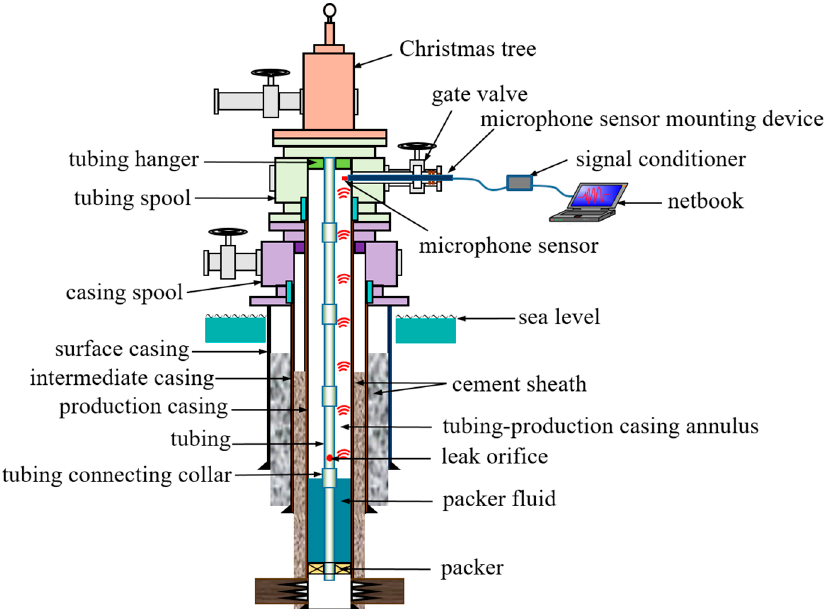
Figure 1. Schematic of the wellbore structure [24] and the detection principle of tubing leakage acoustic waves.